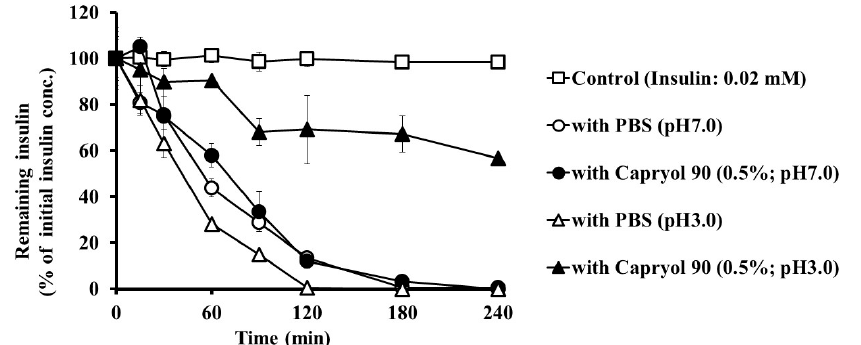
Figure 7. Effects of Capryol 90 and pH on the degradation of insulin in small intestine homogenates at 37 ° C. Each value represents the mean ± S.E. ( n = 3).